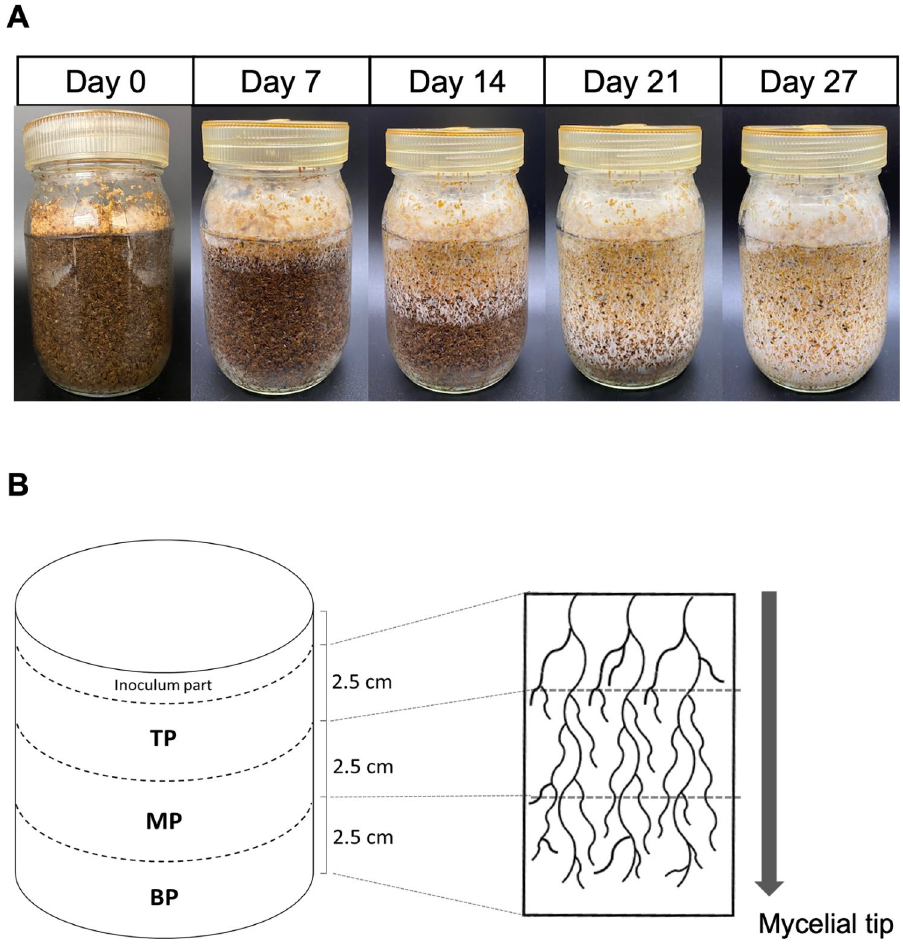
Fig. 1 Growth process of mycelia on sawdust medium and recovery of the medium (A) Sawdust medium was placed in mayonnaise bottles to a height of 7.5 cm. The pre-cultured mycelium was inoculated on the top surface of the medium, and the mycelium elongated toward the bottom side. (B) The mycelium reached the bottom of the bottle at 27 days of incubation, and the medium was cut into three parts of 2.5 cm intervals and collected as the bottom part (BP), middle part (MP), and top part